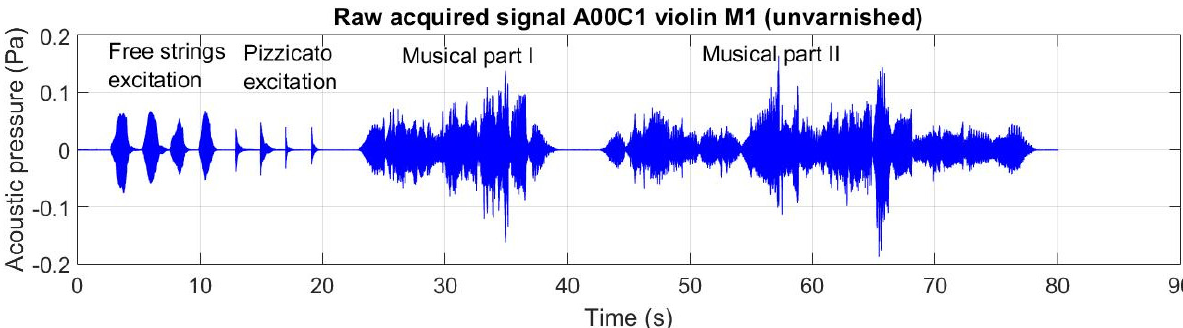
Figure 4. The acoustic signals in time domain, played on the violins.